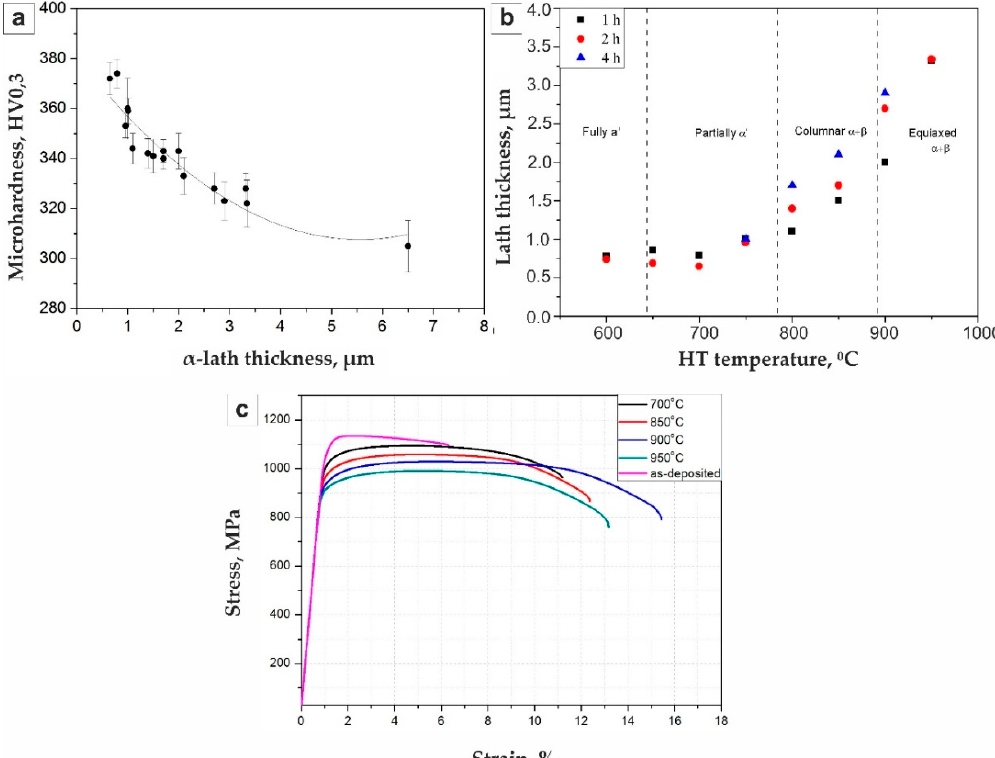
Figure 4. Experimental microhardness measurements for different α -lath thickness values; the tendency line was plotted using polynomial regression analyses ( a ); experimental data of α -lath thickness versus an aging time graph for different temperatures ( b ); typical stress–strain curves of DLD with the Ti-6Al-4V alloy performed with different HT modes ( c ).